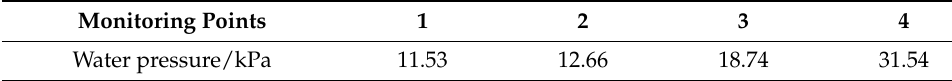
Table 1. The calculation results of initial support external water pressure.